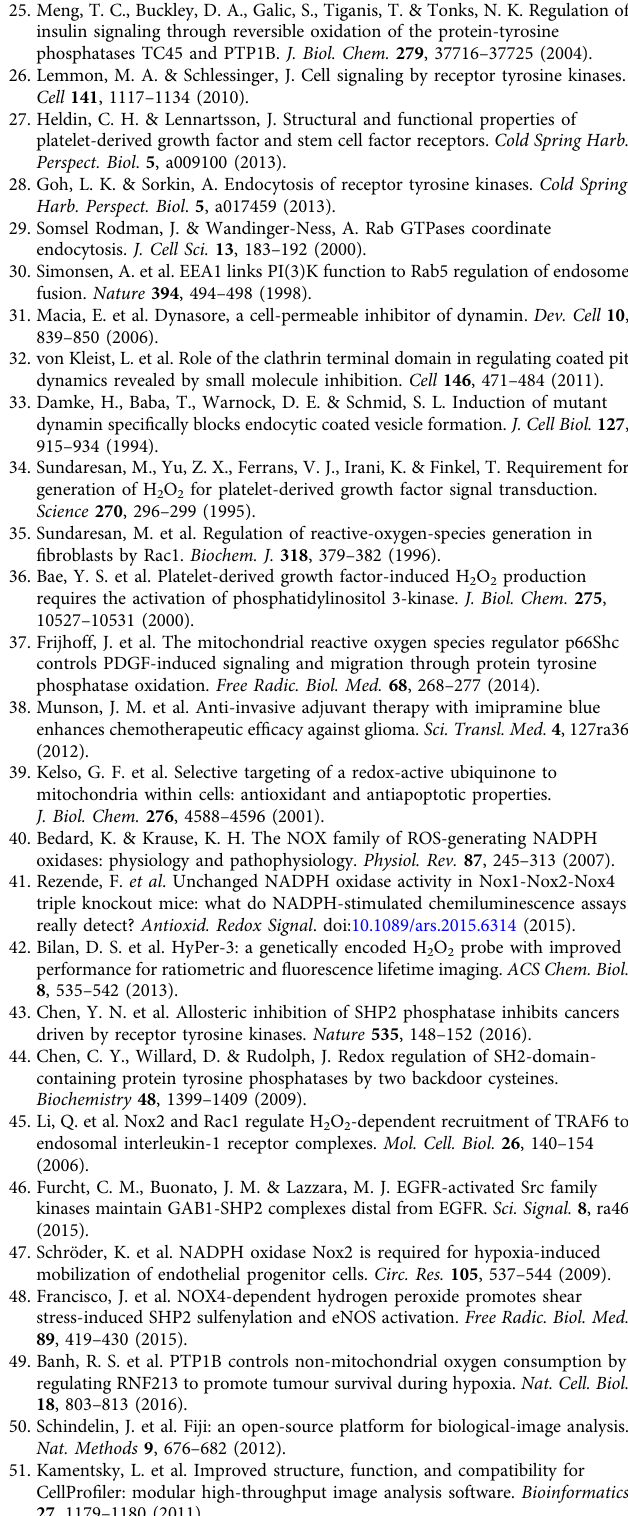
Figs. 1d, 1e, 1g, 2a, 2b, 2c, 2e, 3a, 5a, 6c, 6d) by using StatView software, where appropriate. Precise P -values can be found in the fi